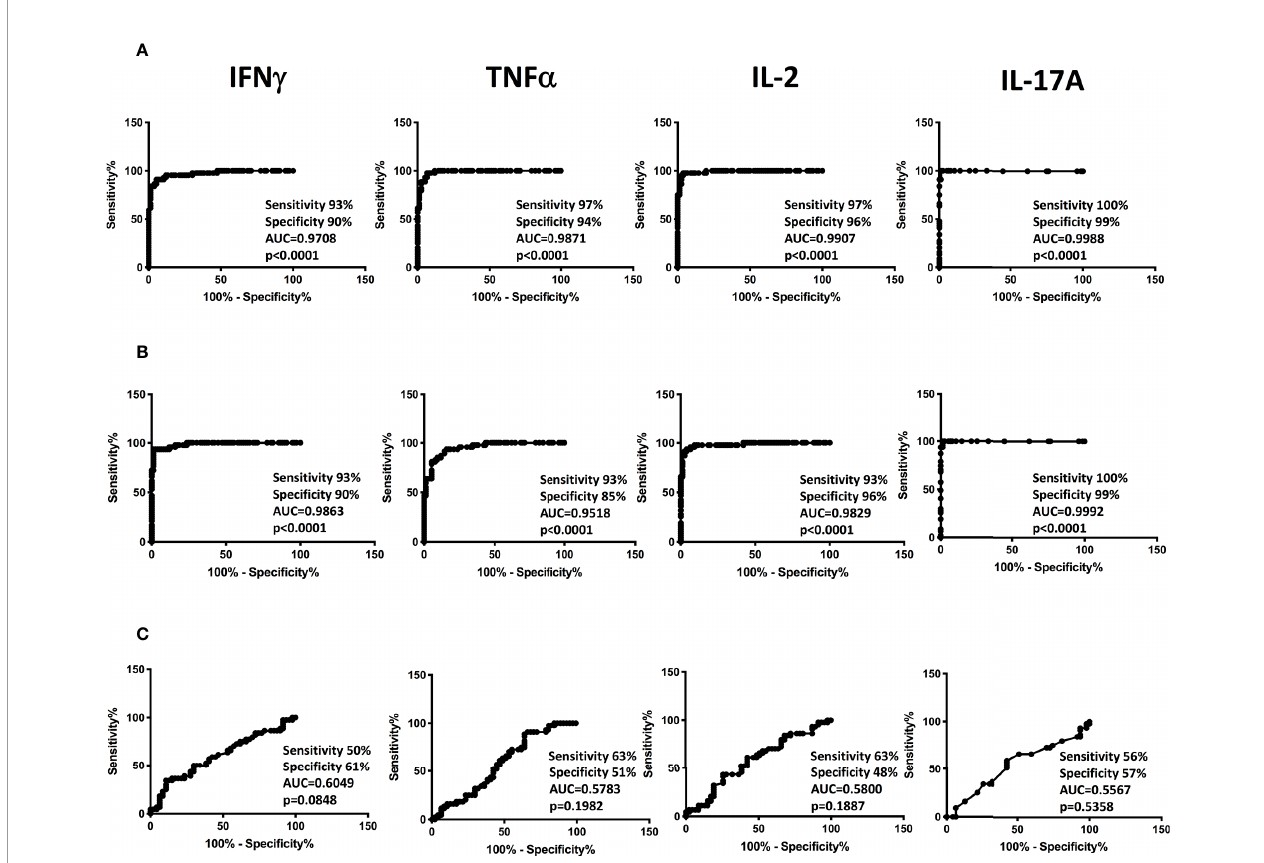
FIGURE 3 | ROC analysis to estimate the discriminatory power of plasma Type 1 and Type 17 cytokines in children with con fi rmed or uncon fi rmed TB and unlikely TB – Discovery cohort. ROC analysis to estimate the sensitivity, speci fi city and AUC was performed using IFN g , TNF a , IL-2, and IL-17A to estimate the capacity of these factors to distinguish individuals with (A) Con fi rmed TB vs. unlikely TB (B) uncon fi rmed TB vs. unlikely TB (C) Con fi rmed vs. uncon fi rmed